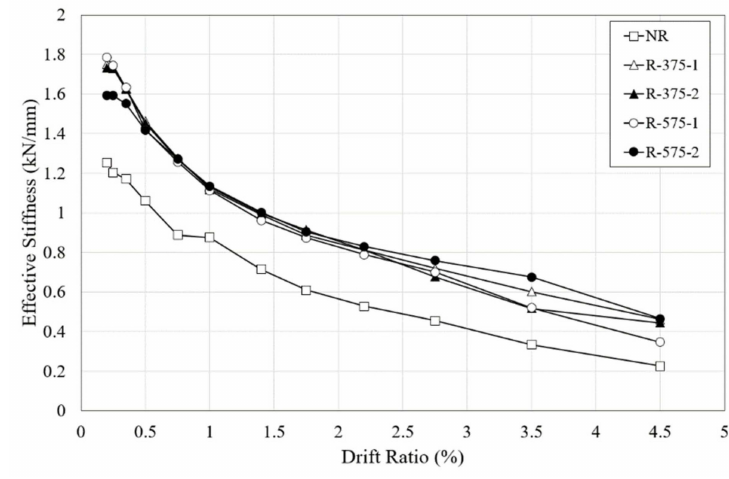
Figure 14. Variation of effective stiffness according to drift ratio.